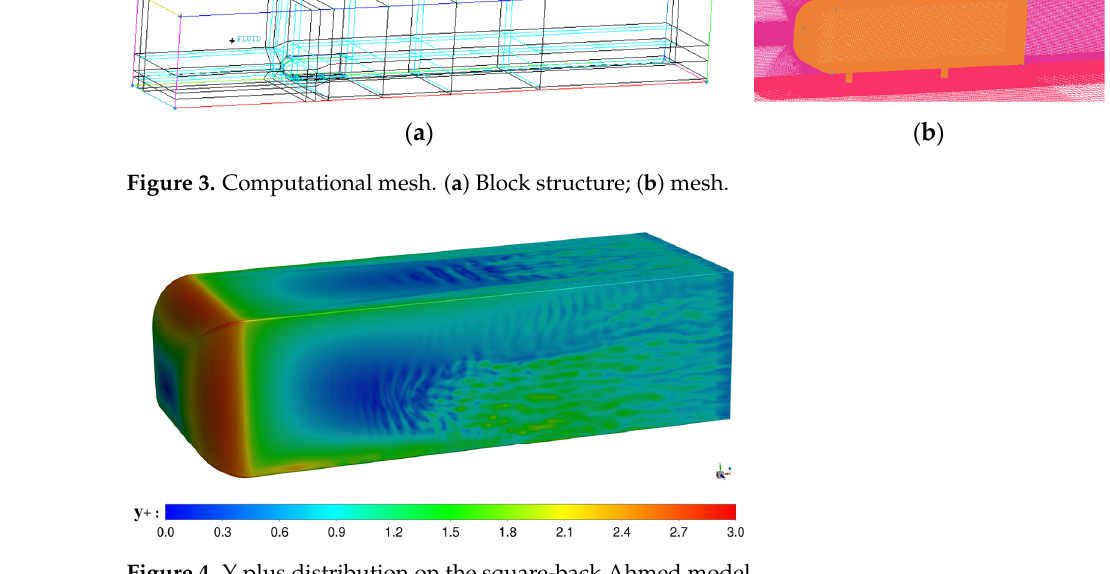
Figure 4. Y plus distribution on the square-back Ahmed model.